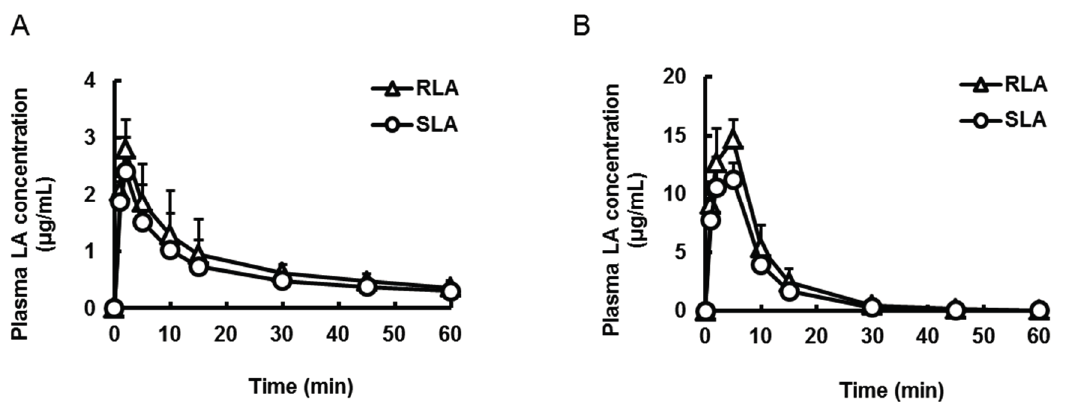
Figure 4. Plasma concentration-time profiles of α -lipoic acid after oral ( A ) and intraduodenal ( B ) administration of the racemic mixture to pylorus ligated rats. Data are shown as mean ± standard deviation ( n =